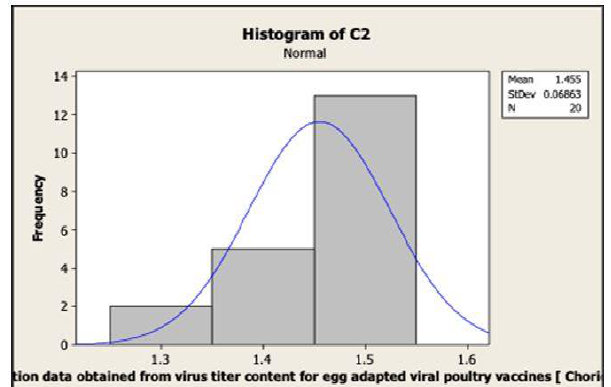
Fig.2: Normal distribution at confidence level 95% for virus titer content by chorioallantoic route.